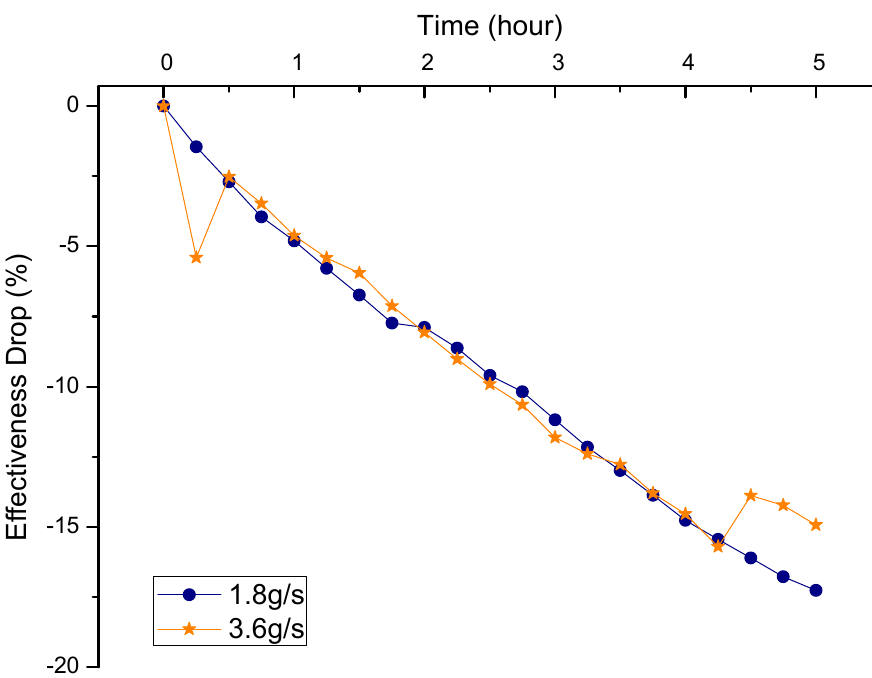
Figure 6. Decline in effectiveness over the course of 5 h with respect to different flow rates. Engine speed: 2000 rpm, BMEP: 6 bar, coolant temperature: 60 °C, and EGR inlet gas temperature: 420 °C.